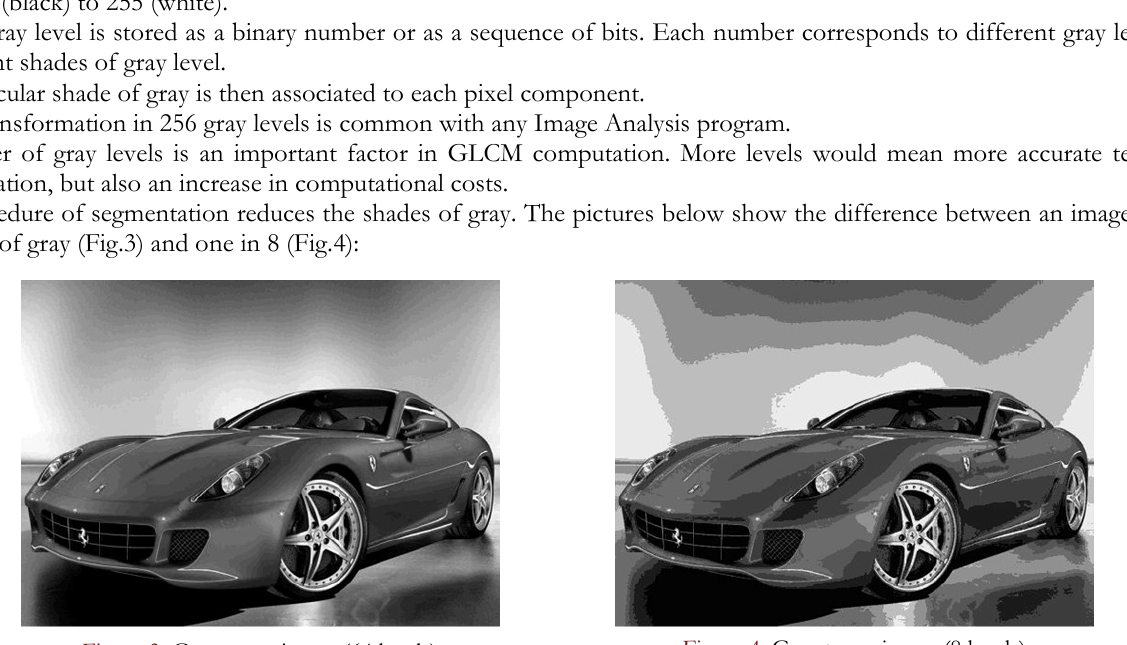
Figure 3: Gray tones image (64 levels) Figure 4: Gray tones image (8